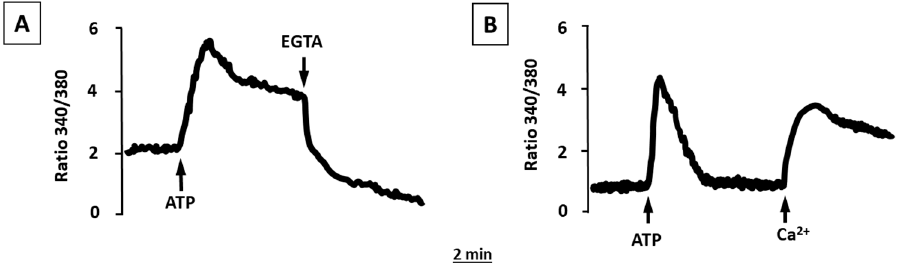
Figure 2. Effects of ATP on [Ca 2+ ] i concentrations in human differentiated white adipocytes. Human adipocytes, grown and differentiated in adipogenic medium on glass coverslips, were loaded with fura-2/AM, as described in the Section 4. ( A ) Adipocytes suspended in Ca 2+ -containing medium. ( B ) Adipocytes suspended in Ca 2+ -free medium. Where indicated, ATP (100 μ M), EGTA (1 mM), and Ca 2+ (1 mM) were added. Traces are representative of the fluorescence ratio F340/F380 of a typical experiment from three.